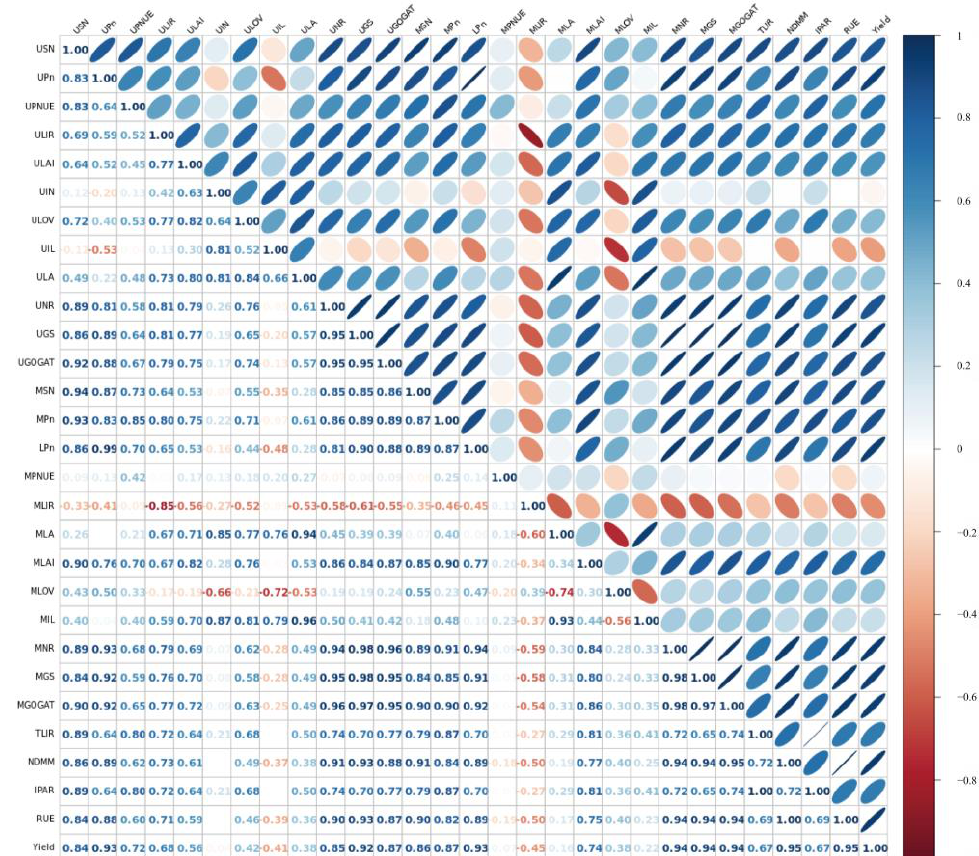
Figure 6. Correlation analysis of PAR utilization (RUE), canopy PAR intercept (IPAR), leaf N content, and grain yield at different N fertilization levels in 2015. USN and MSN, silking N content of the upper and middle leaf. UPn and MPn, net photosynthetic rate of upper and middle layer; UPNUE and MPNUE, photosynthetic N use efficiency of upper and middle layer; ULIR and MLIR, light intercept rate of upper and middle layer; ULAI and MLAI, upper and middle leaf area index; UIN, the internode number of upper layer; UIL and MIL, the internode length of upper and middle layer; ULA and MLA, leaf angle of upper and middle layer; ULOV and MLOV, leaf orientation value upper layer and middle layer; UGS and MGS, glutamine synthase activity of upper and middle leaf; UGOGAT and MGOGAT, glutamate synthase activity of upper and middle leaf; UNR and MNR, nitrate reductase activity of upper and middle leaf; NDMM, the dry matter accumulation, IPAR; the canopy PAR intercept; RUE, the PAR utilization; TLIR, total light intercept rate.